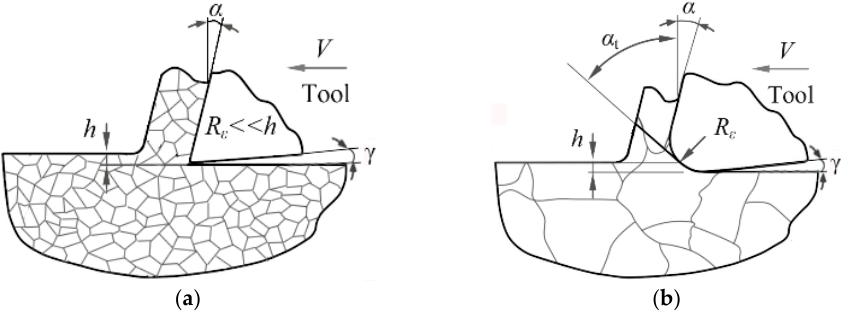
Figure 1. The effective rake angle during the cutting process. ( a ) Traditional machining manner; ( b ) micro-machining removal manner.